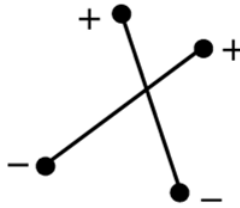
0 Figure 8. Network of fibers with crossing points between their segments.